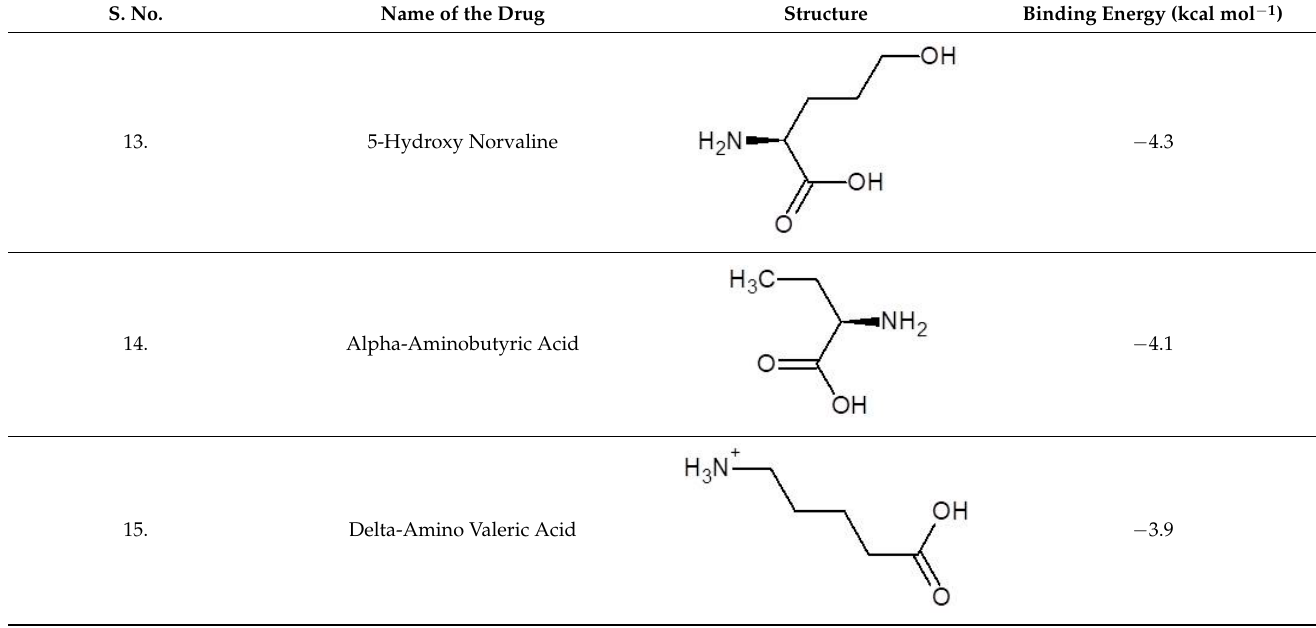
Table 2. Structures and binding energies of drugs that have substructures of L